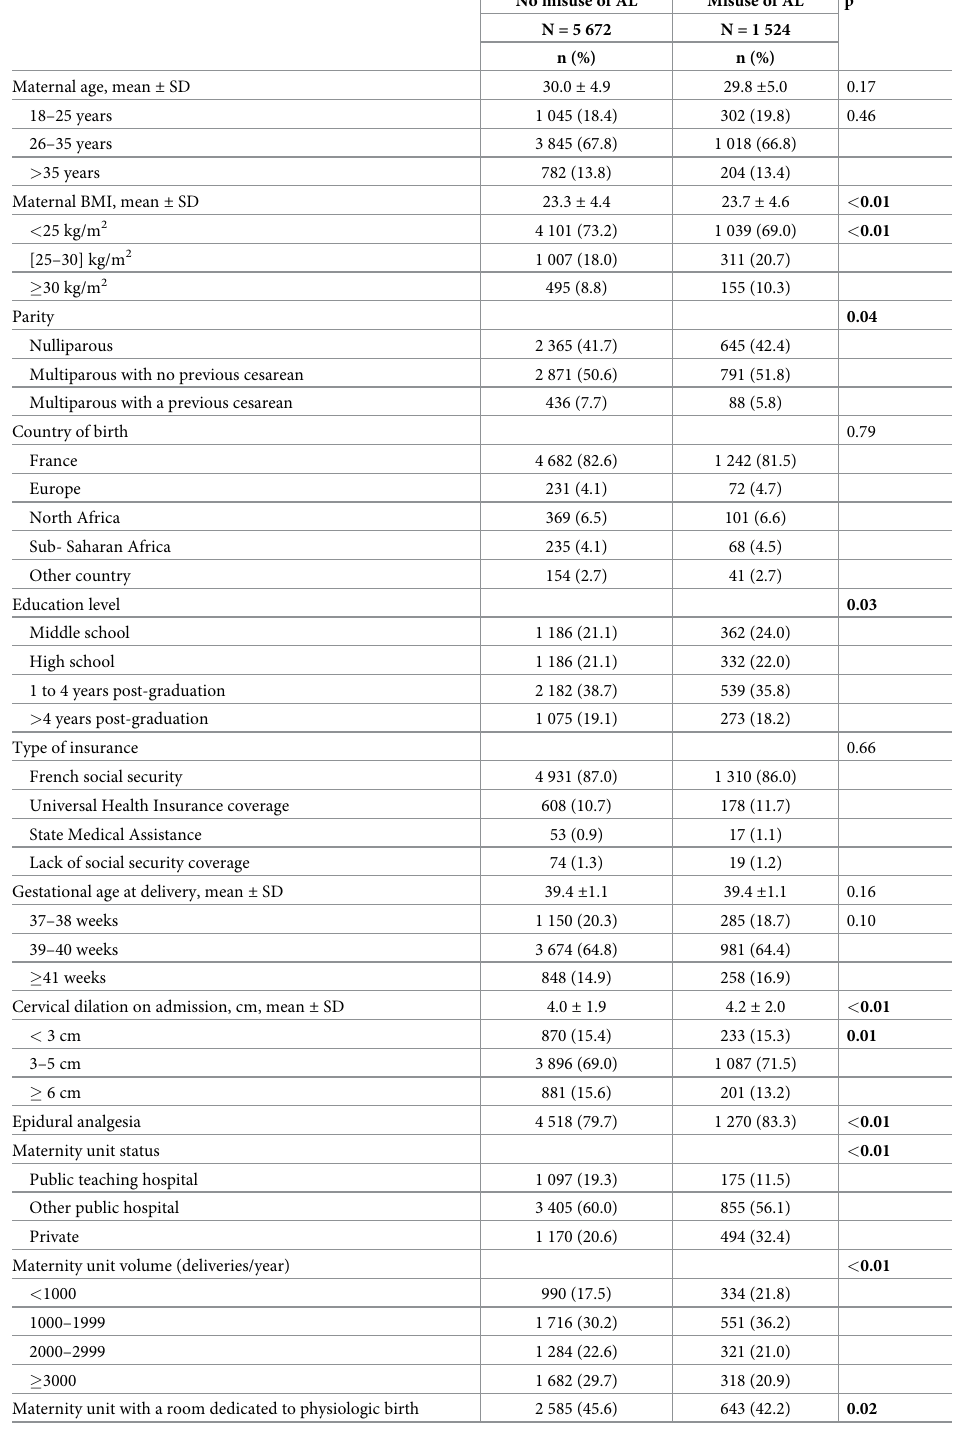
Table 1. Comparison of women’s characteristics, labor characteristics and maternity unit’s characteristics between women with no misuse of Augmentation of Labor (AL) and women with misuse of augmentation of